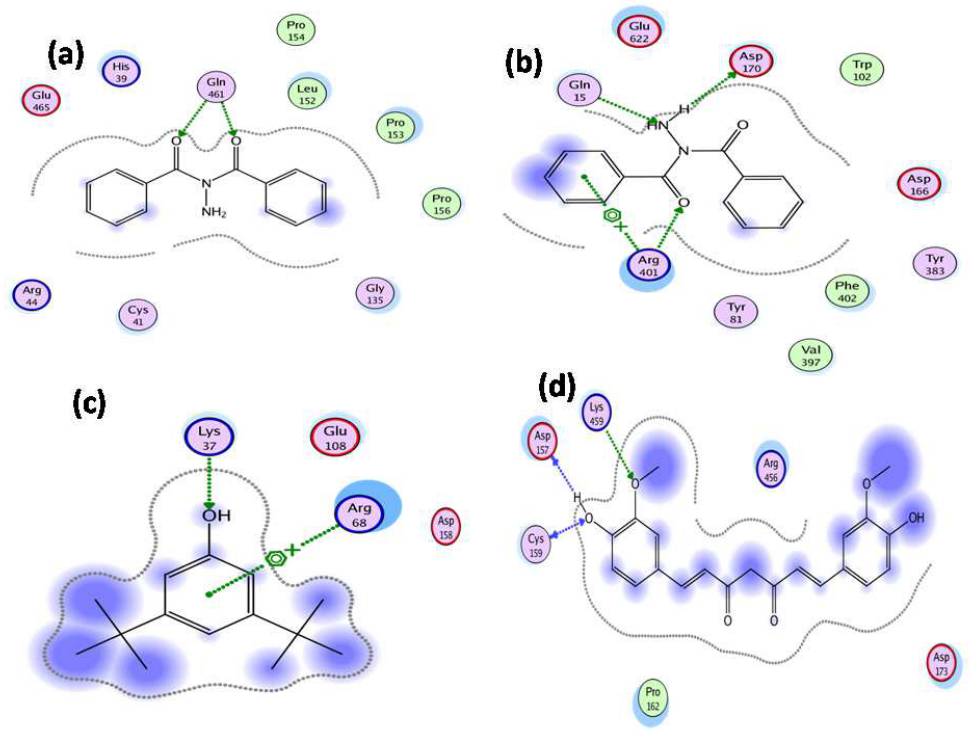
Figure 3. Two dimensional images (2D) of ( a ) dibezoylhydrazine with COX-2, ( b ) dibezoylhydrazine with 5-LOX, ( c ) 7-acetyl-2-hydroxy-2-methyl-5-isopropylbicyclo [4.3.0]nonane with 5-LOX, and ( d ) 6-Octadenoic acid, methyl ester with COX-2.